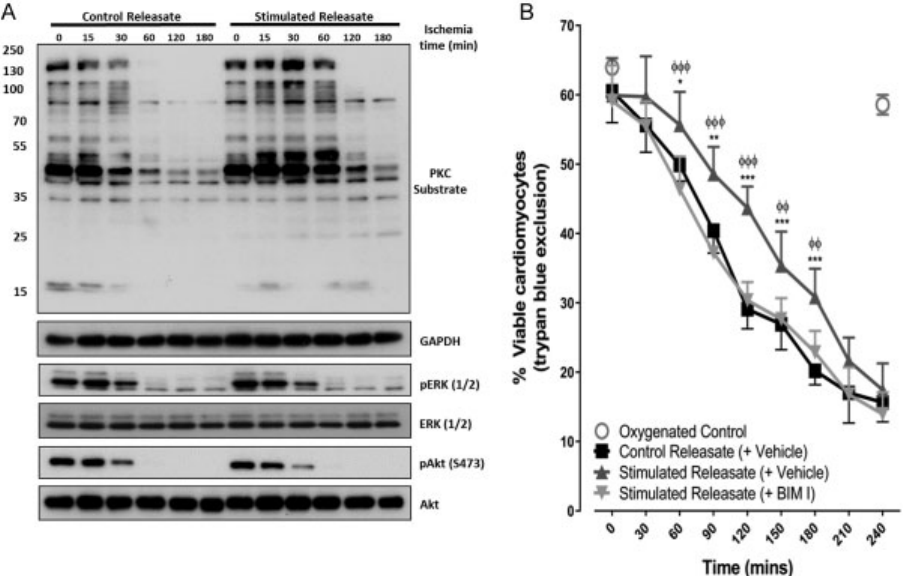
Fig. 3 Protein kinase C (PKC) activity is essential for platelet releasate-mediated cardioprotection. ( A ) Cardiomyocytes preconditioned with releasates from vehicle- (control) and CRP- (stimulated) treated WT platelets were subjected to ischemic injury, with samples removed from the pellet and lysed at indicated ischemic time points. Samples were monitored for changes in PKC activity (Phospho serine PKC substrate), phospho Akt (Ser473), and Erk 1/2 (Thr202/Tyr204) by immunoblotting with speci fi c antibodies followed by appropriateloading controls. Blots shown are representative of three independent experiments. ( B ) Cardiomyocytes were pretreated in the absence ( þ DMSO vehicle) or presence of 10 µM BIM I for 30 minutes prior to preconditioning with releasates from vehicle- (control) and CRP-treated (stimulated) WT platelets, then monitored for cardiomyocyte viability for up to 240 minutes of ischemic injury, with nonischemic (oxygenated control) samples monitored at 0- and 240- minute time points. Data are mean (cid:4) SD; n ¼ 4, (cid:5) p < 0.05, (cid:5)(cid:5) p < 0.01, (cid:5)(cid:5)(cid:5) p < 0.001 versus control releasate, ΦΦ p < 0.01, ΦΦΦ p < 0.001 versus stimulated releasate ( þ BIM I). Two-way ANOVA with Bonferroni post hoc test. TH Open Vol. 1 No.